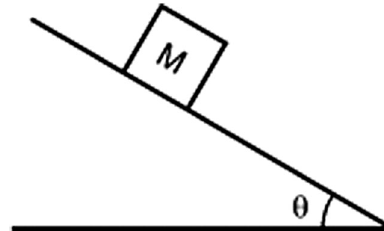
FIG. 12. Figure for friction post-test problems 10 – 11.